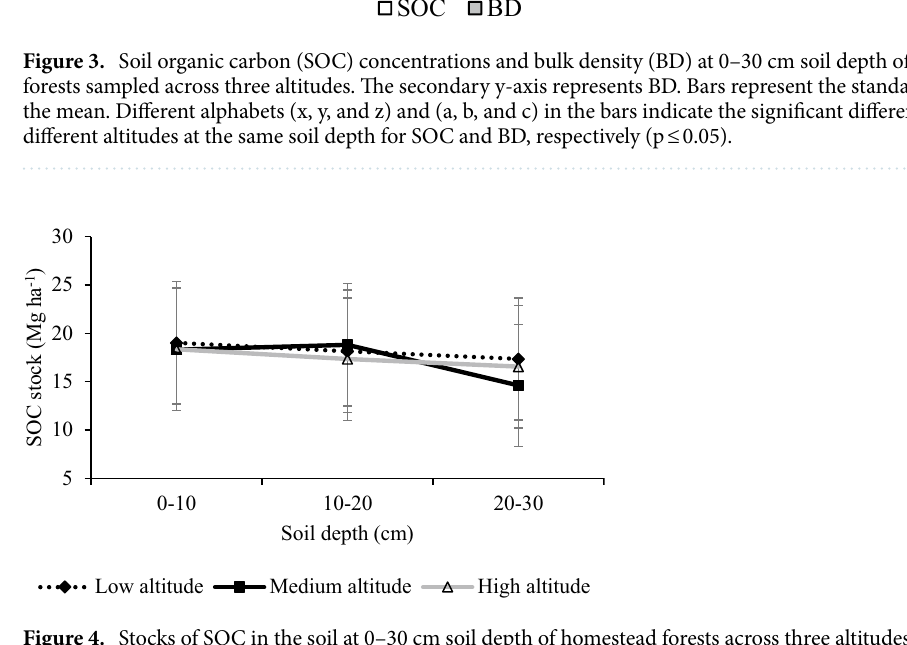
Figure 4. Stocks of SOC in the soil at 0–30 cm soil depth of homestead forests across three altitudes. Bars represent the standard error of the